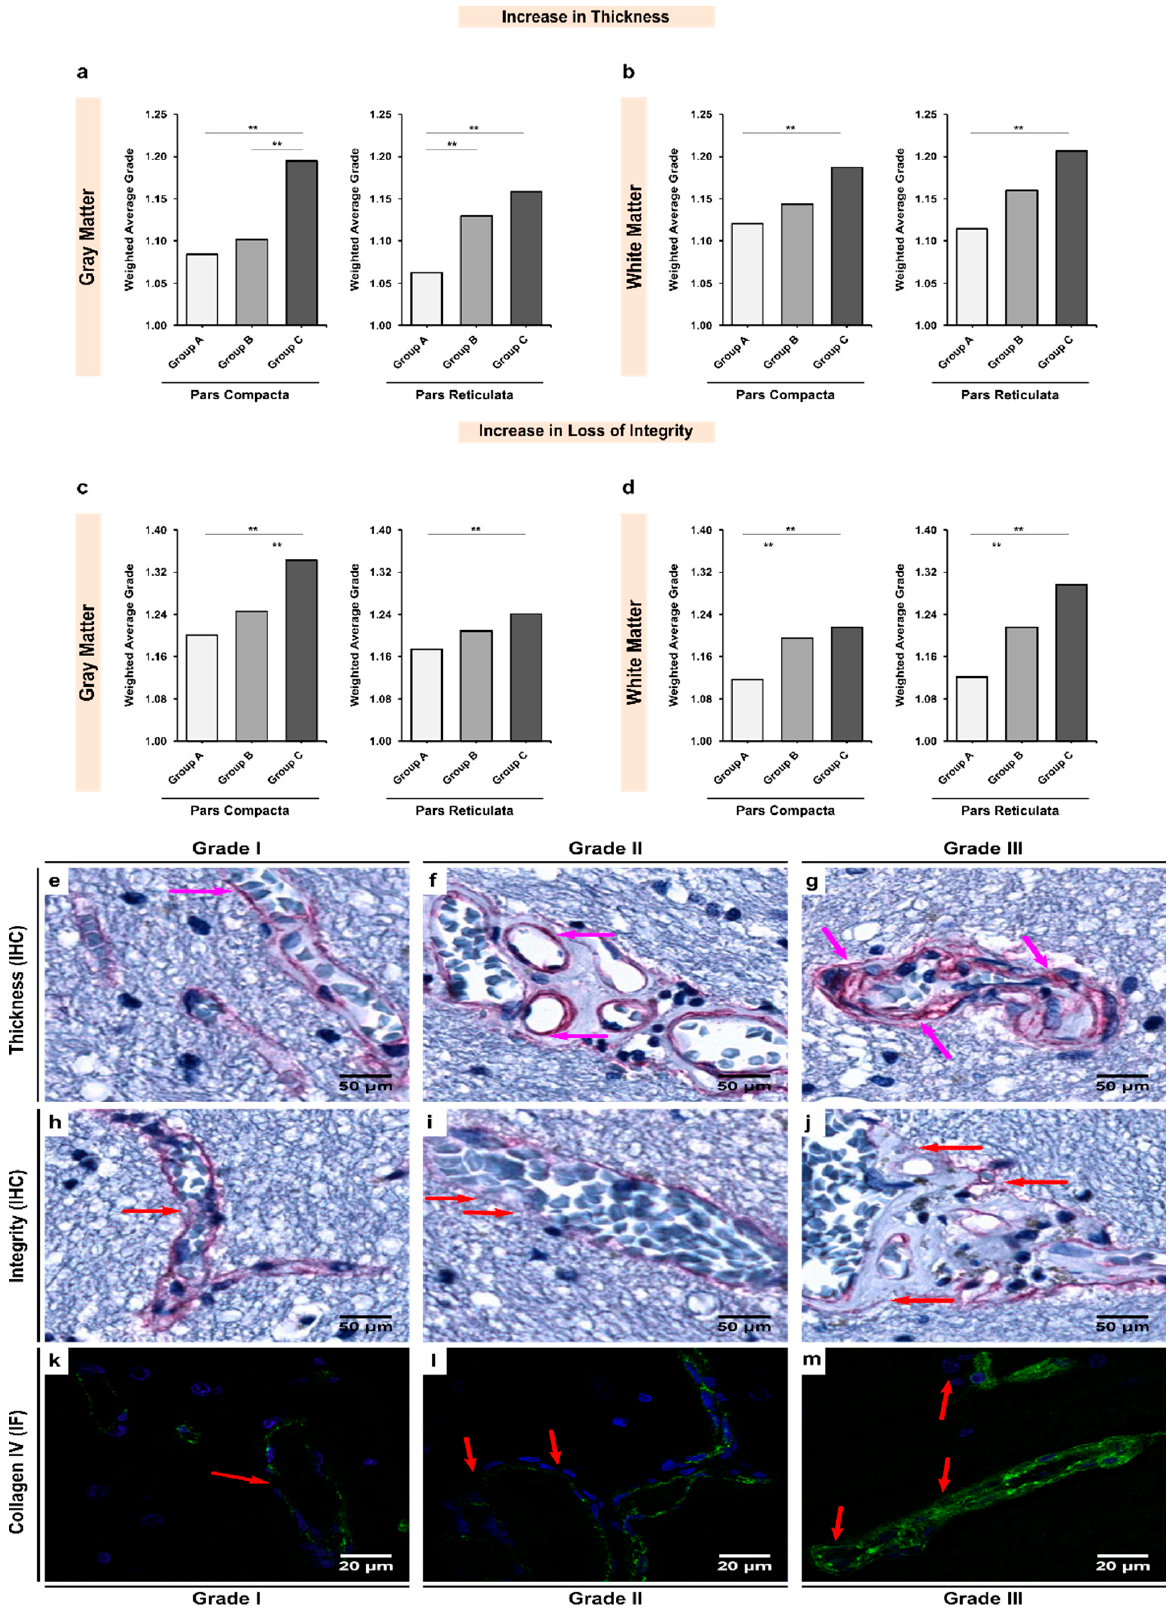
Figure 3. Inter-group analysis of the increase in ( a , b ) thickness and ( c , d ) loss of integrity of the BM based on the expression of collagen-IV in the microvessels in the ( a,c ) gray matter and ( b , d ) white matter of the SN region. Group A represent controls, group B represents young alcoholics, whilst group C represents chronic alcoholics. The bar plots indicate the weighted average grading of all the visualized blood vessels in each group; ** indicates a significant difference between the groups ( p < 0.05 with Bonferroni correction is considered as significant). Representative photomicrographs showing the different grades of BM thickness and integrity based on the expression of collagen-IV as